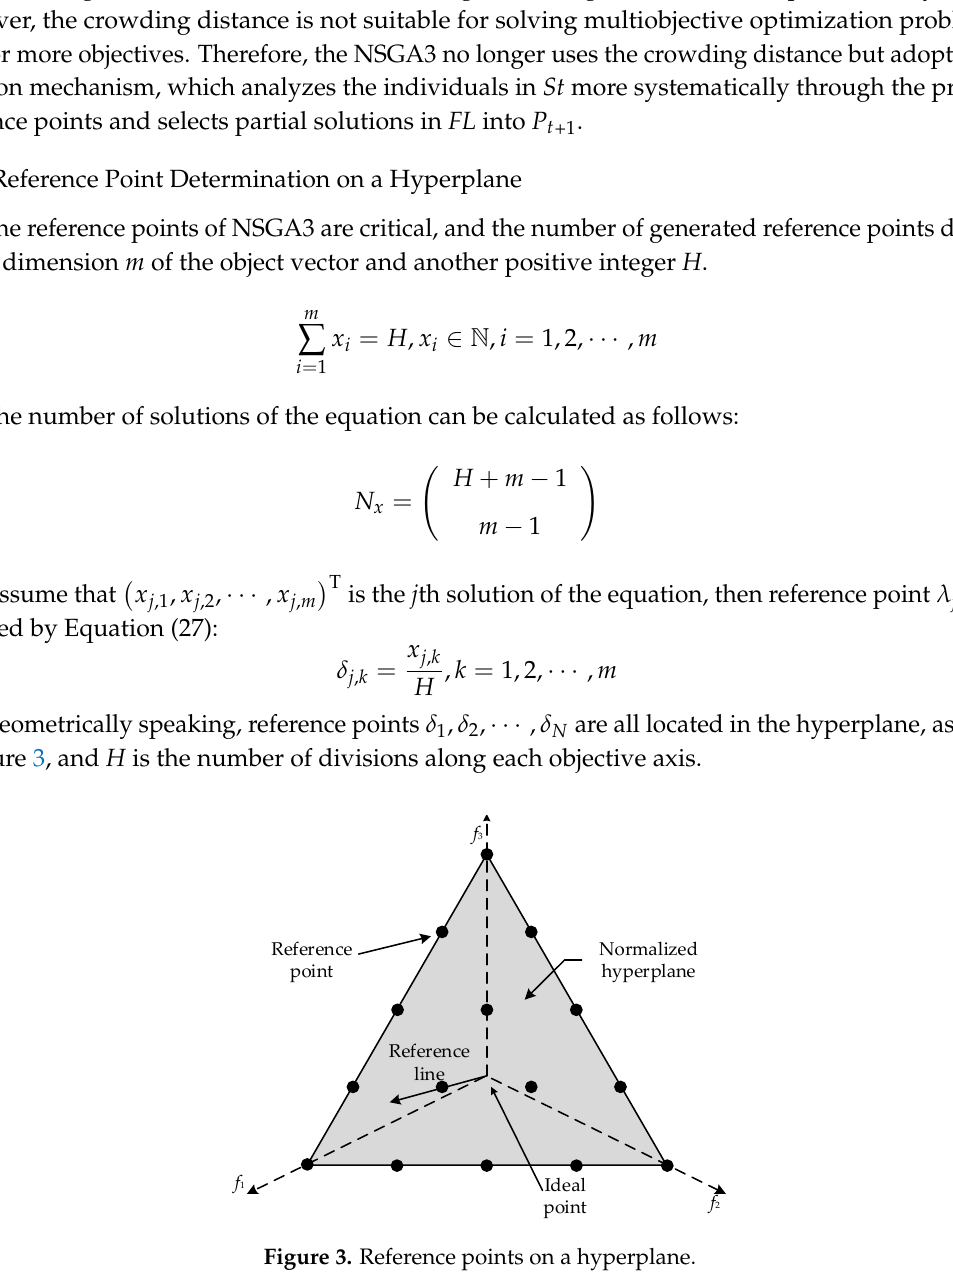
z 2max Figure 4. Computing intercepts and forming the hyperplane from extreme points.